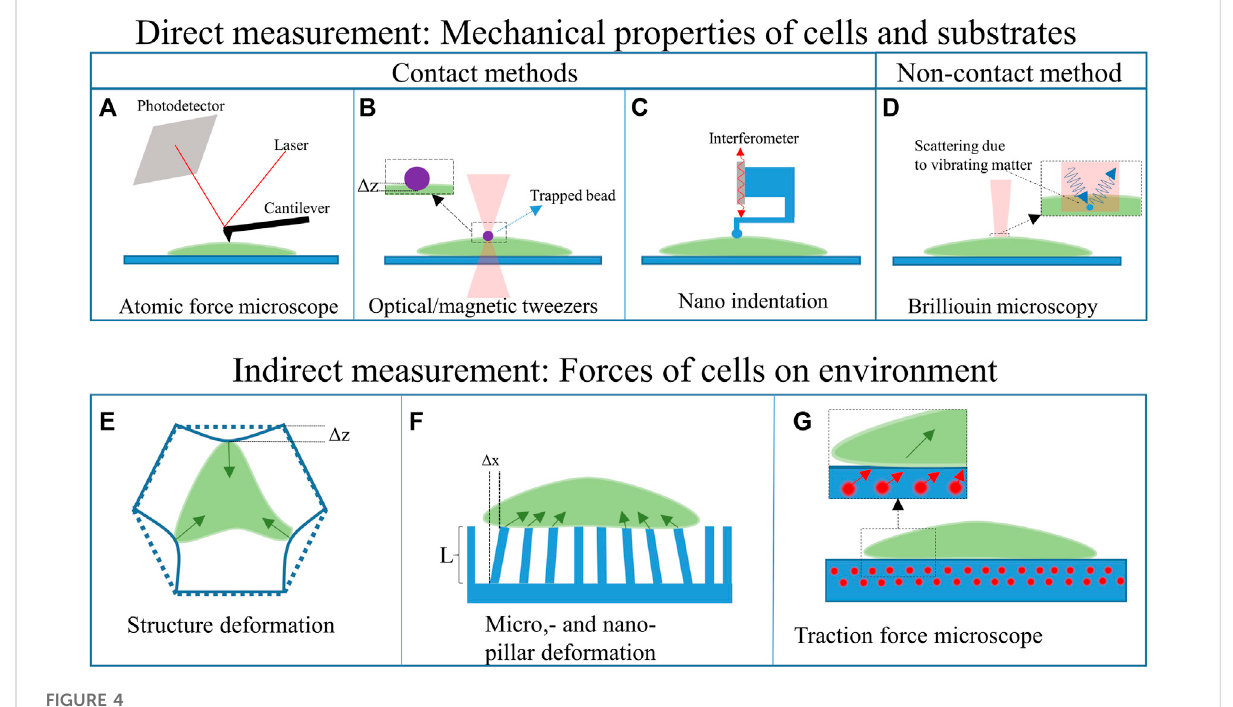
FIGURE 4 Overview of the techniques employed to measure cell mechanical